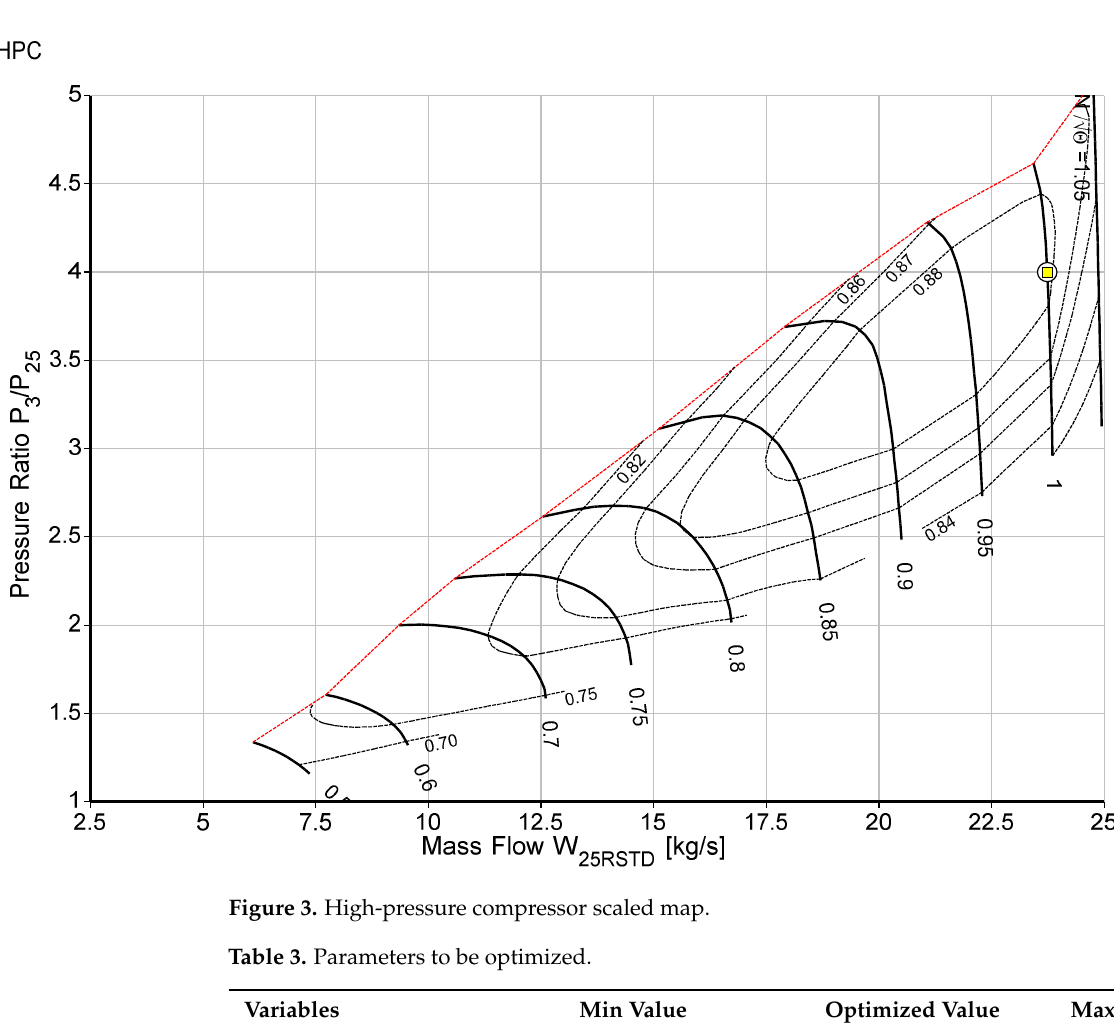
Figure 2. Booster/low-pressure compressor scaled map.